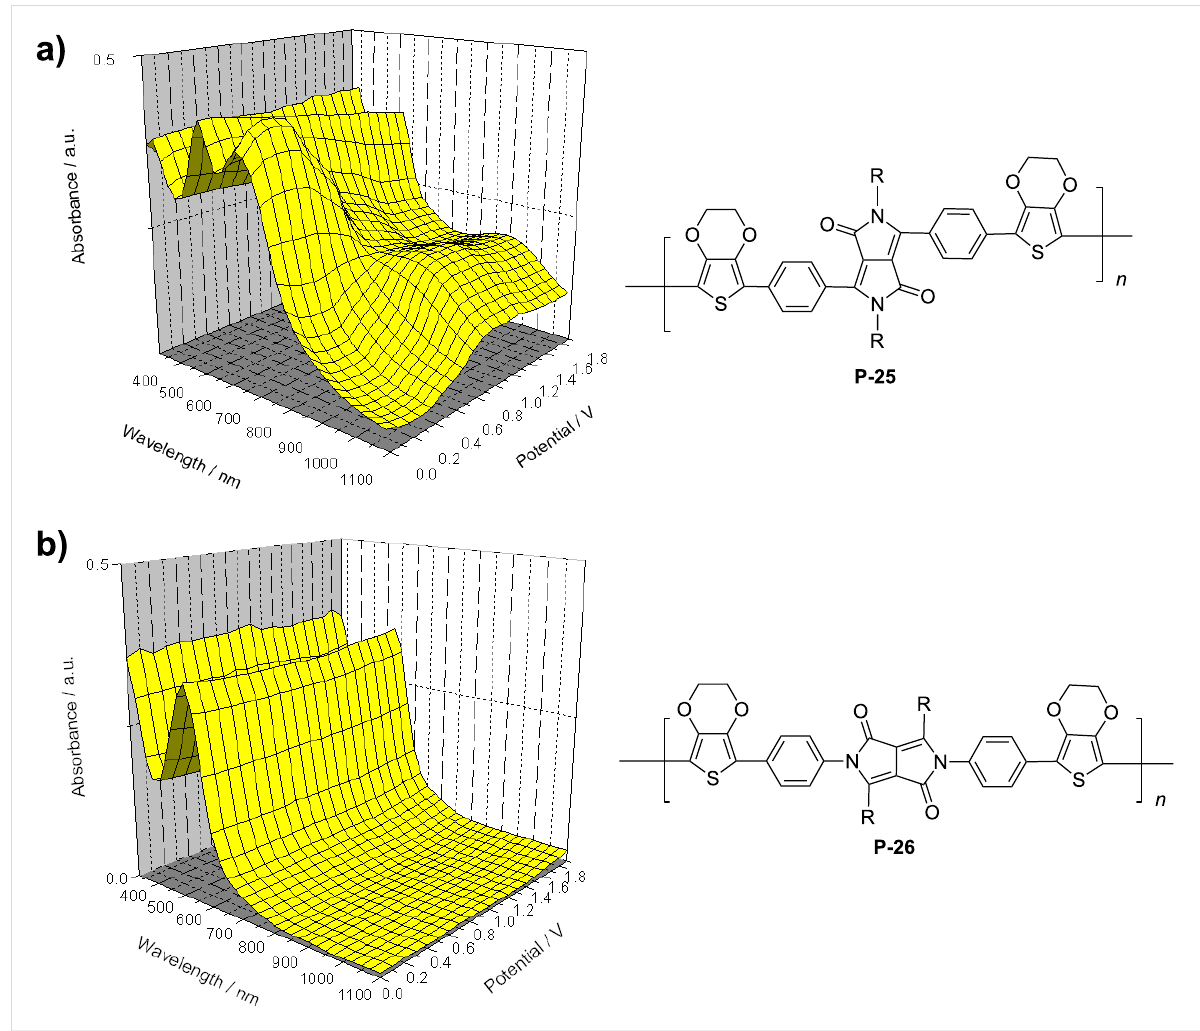
Figure 5: Absorption spectroelectrochemical plots of P-25 and P-26 as thin films on ITO glass. Scan rate: 100 mVs − 1 ; potential vs. ferrocene (from [50]).